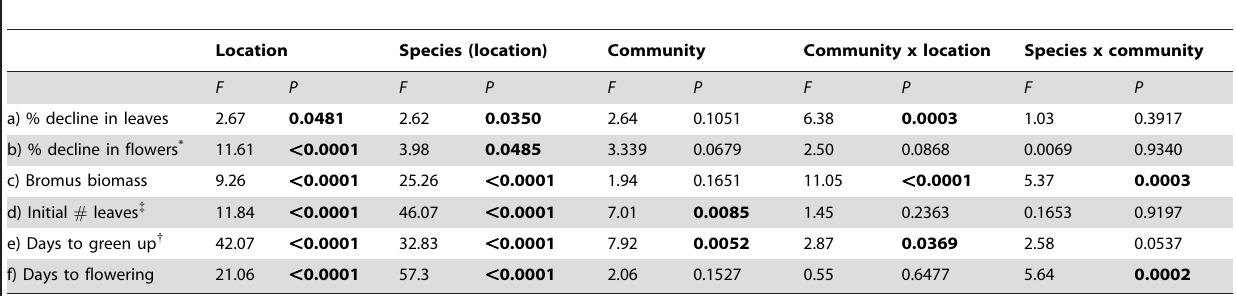
Table 2. Results from ANOVA analysis showing the effect of collection location, species (nested in location), community type (invaded or uninvaded), and their interactions on response